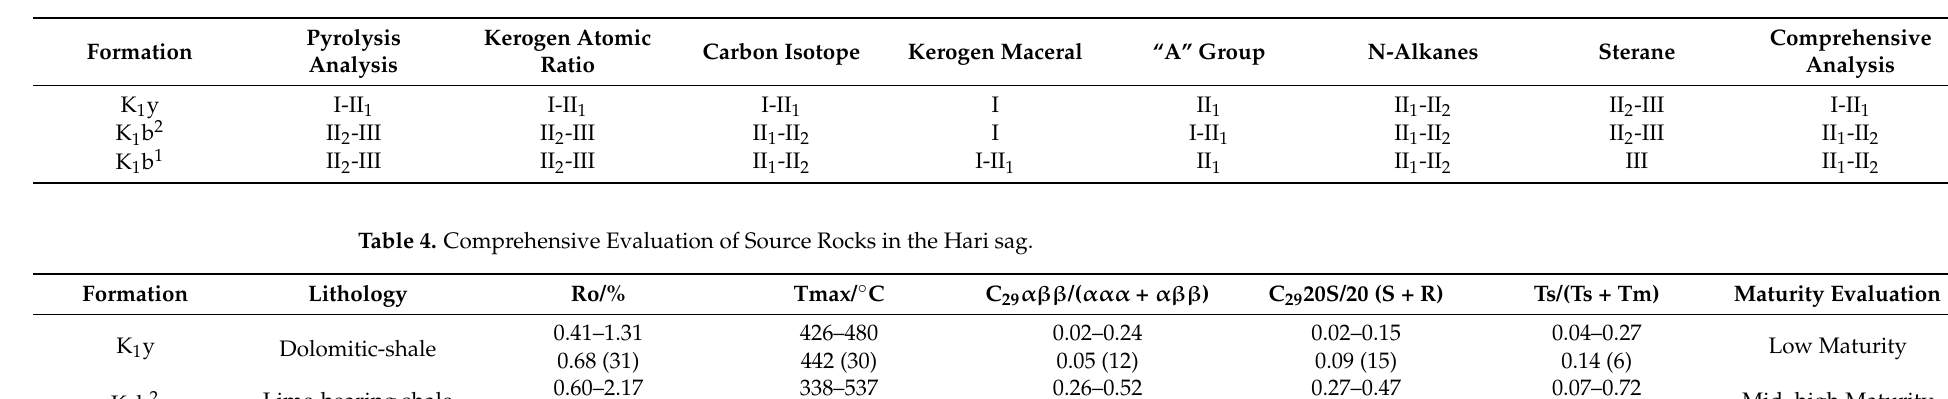
Table 3. Evaluation of kerogen types for main source rocks in the Hari sag.